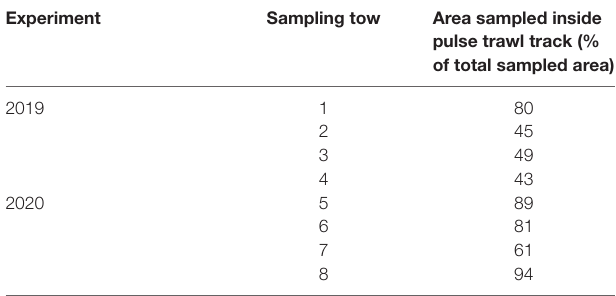
TABLE 3 | Estimates for the areas swept inside the pulse trawl track by the sampling trawl. Experiment